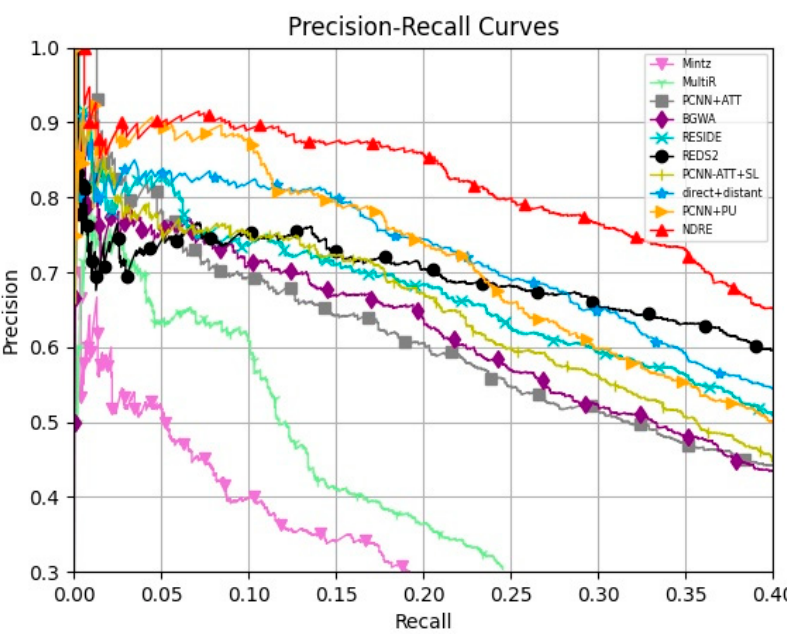
Figure 4. Aggregate precision–recall curves of our model and compared baseline methods.